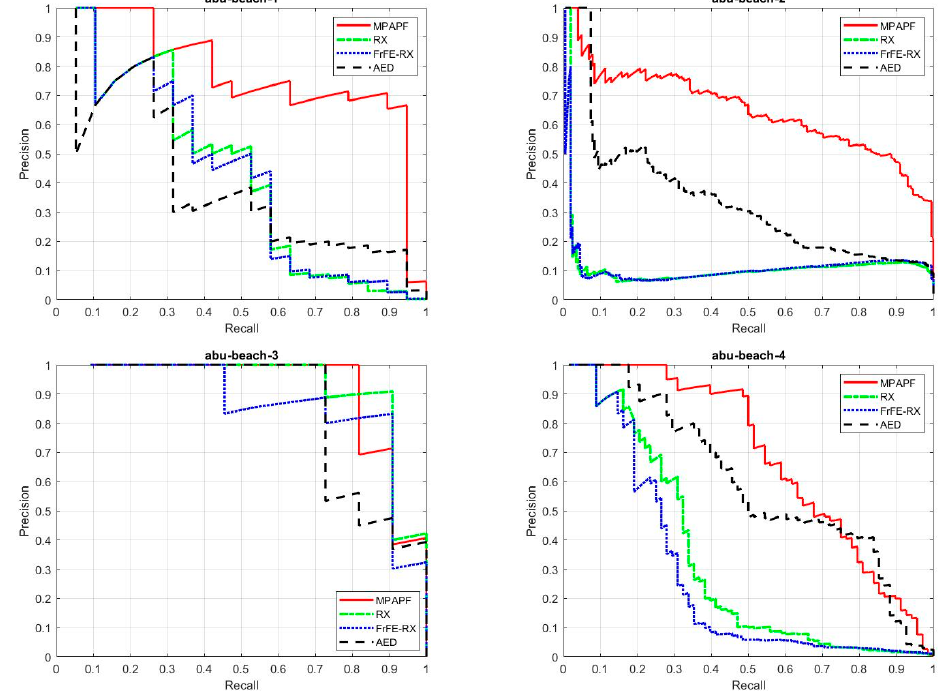
Figure 11. Precision-recall curves of the compared methods on the ABU-Beach Scene.